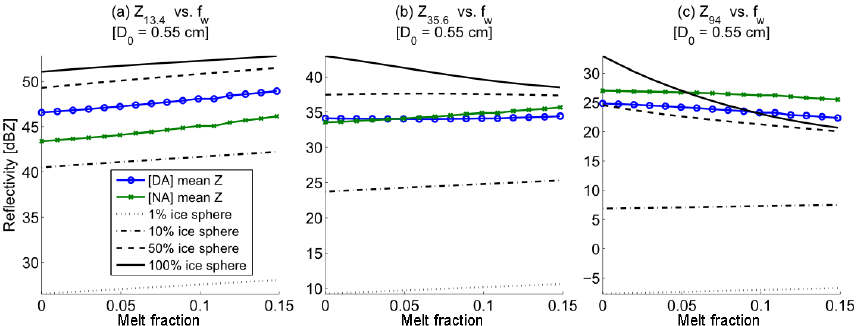
Figure 12. Similar to Fig. 11 except for a larger D 0 = 0 . 55cm. Notice the flip in the computed reflectivities at 94GHz, similar to what was observed in the single-particle backscattering properties (Fig. 7). Note: the results in this figure may be subject to large particle diameter truncation, as discussed in the text.